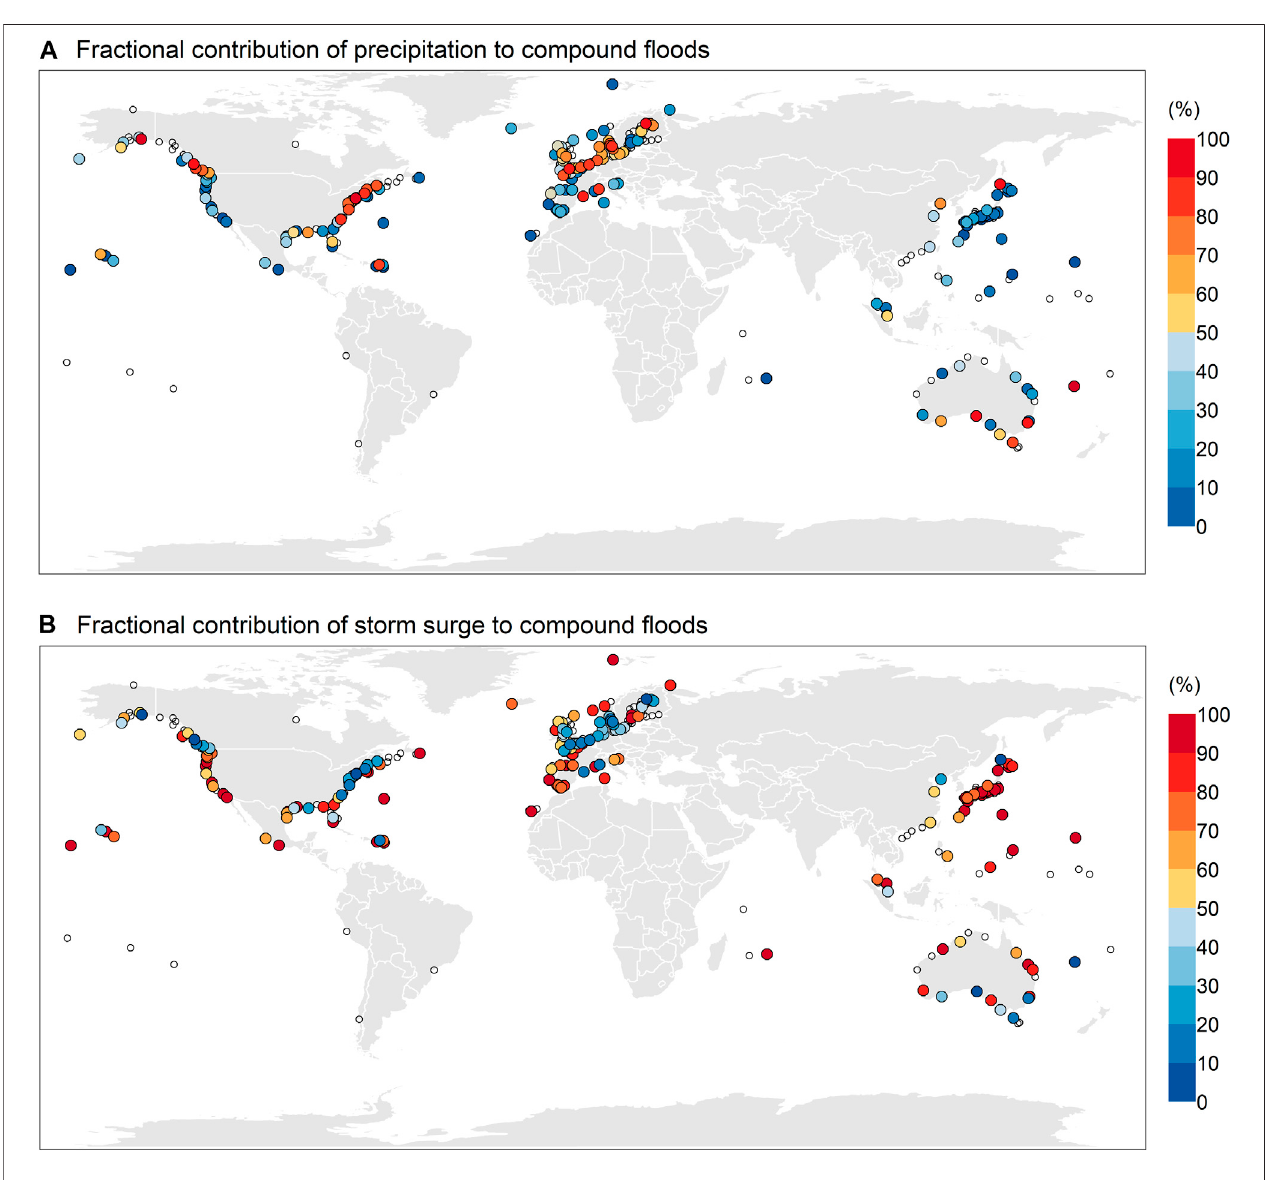
FIGURE6| Fractionalcontributionof (A) changesinprecipitationand (B) stormsurgetothechangesinnumberofcompound fl ooddays.Opencirclesdenotethat the Sen ’ s slope of the number of compound fl ood days is 0.